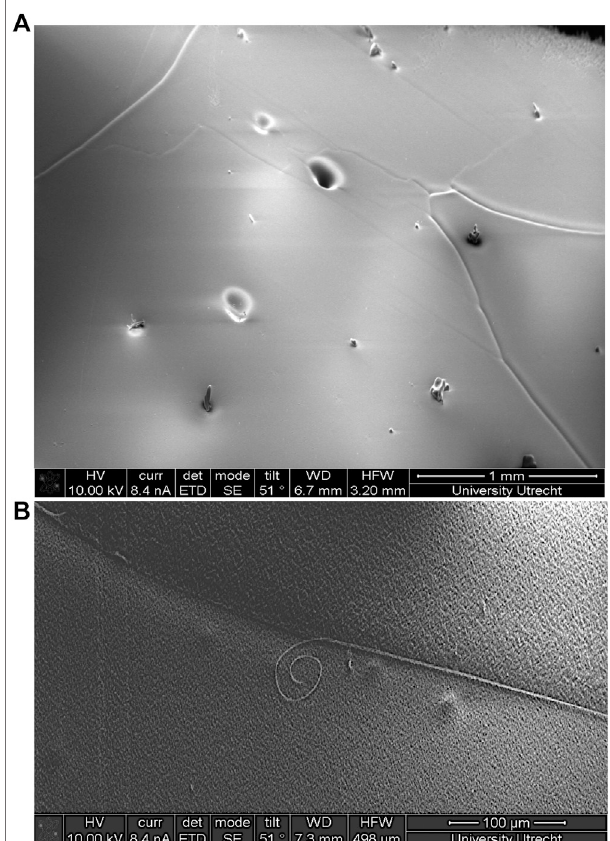
FIGURE 5 | SEM-images from a depth of 2035.9 m of the European Project for Ice Coring in Antarctica in Dronning Maud Land (EDML) ice core, Antarctica (Stoll and Weikusat, 2020). (A) Sample surface after polishing and sublimation. Deep grooves are grain boundaries, shallow grooves are subgrain boundaries, roundish dents are bubbles, and objects on the surface are frost particles. (B) Filament at a grain boundary. Summarising SEM- imagesfrom,e.g.,Figure4fromCullenandBaker(2000),Figure6fromCullen and Baker (2001), Figure 1 from Barnes et al. (2002a), and Figures 4a and 5a from Baker et al.